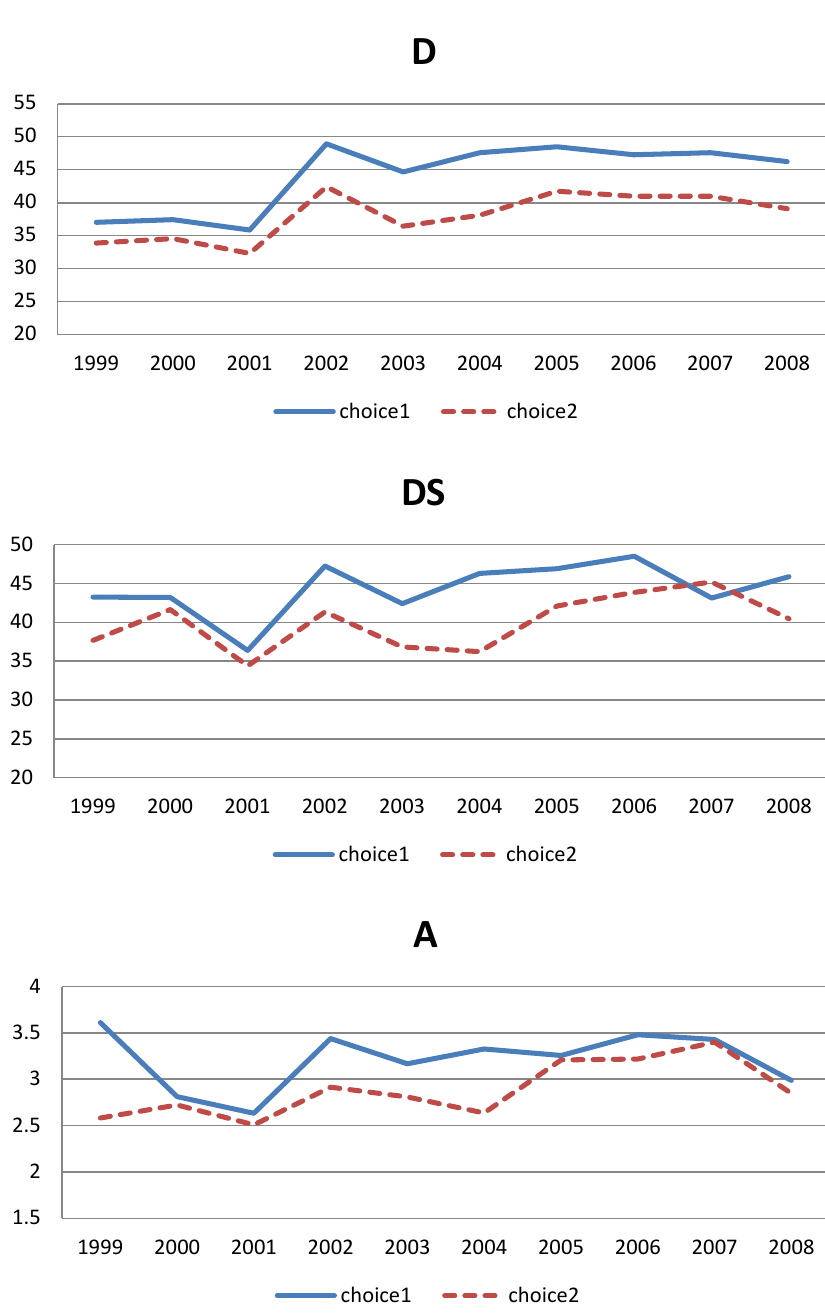
Figure 3: The level of horizontal sex segregation, Index of dissimilarity by choice, TECH